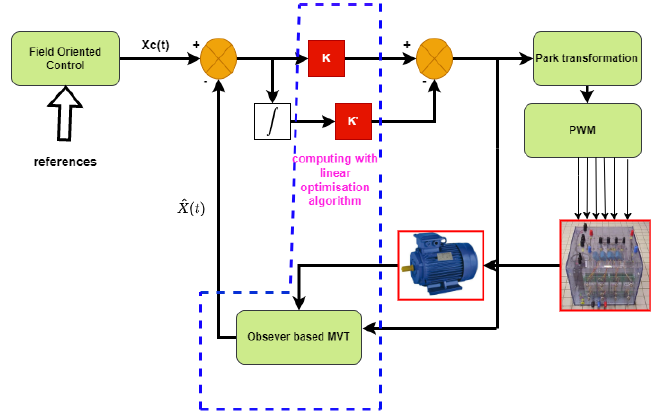
Figure 4. Observer-based state feedback control structure.